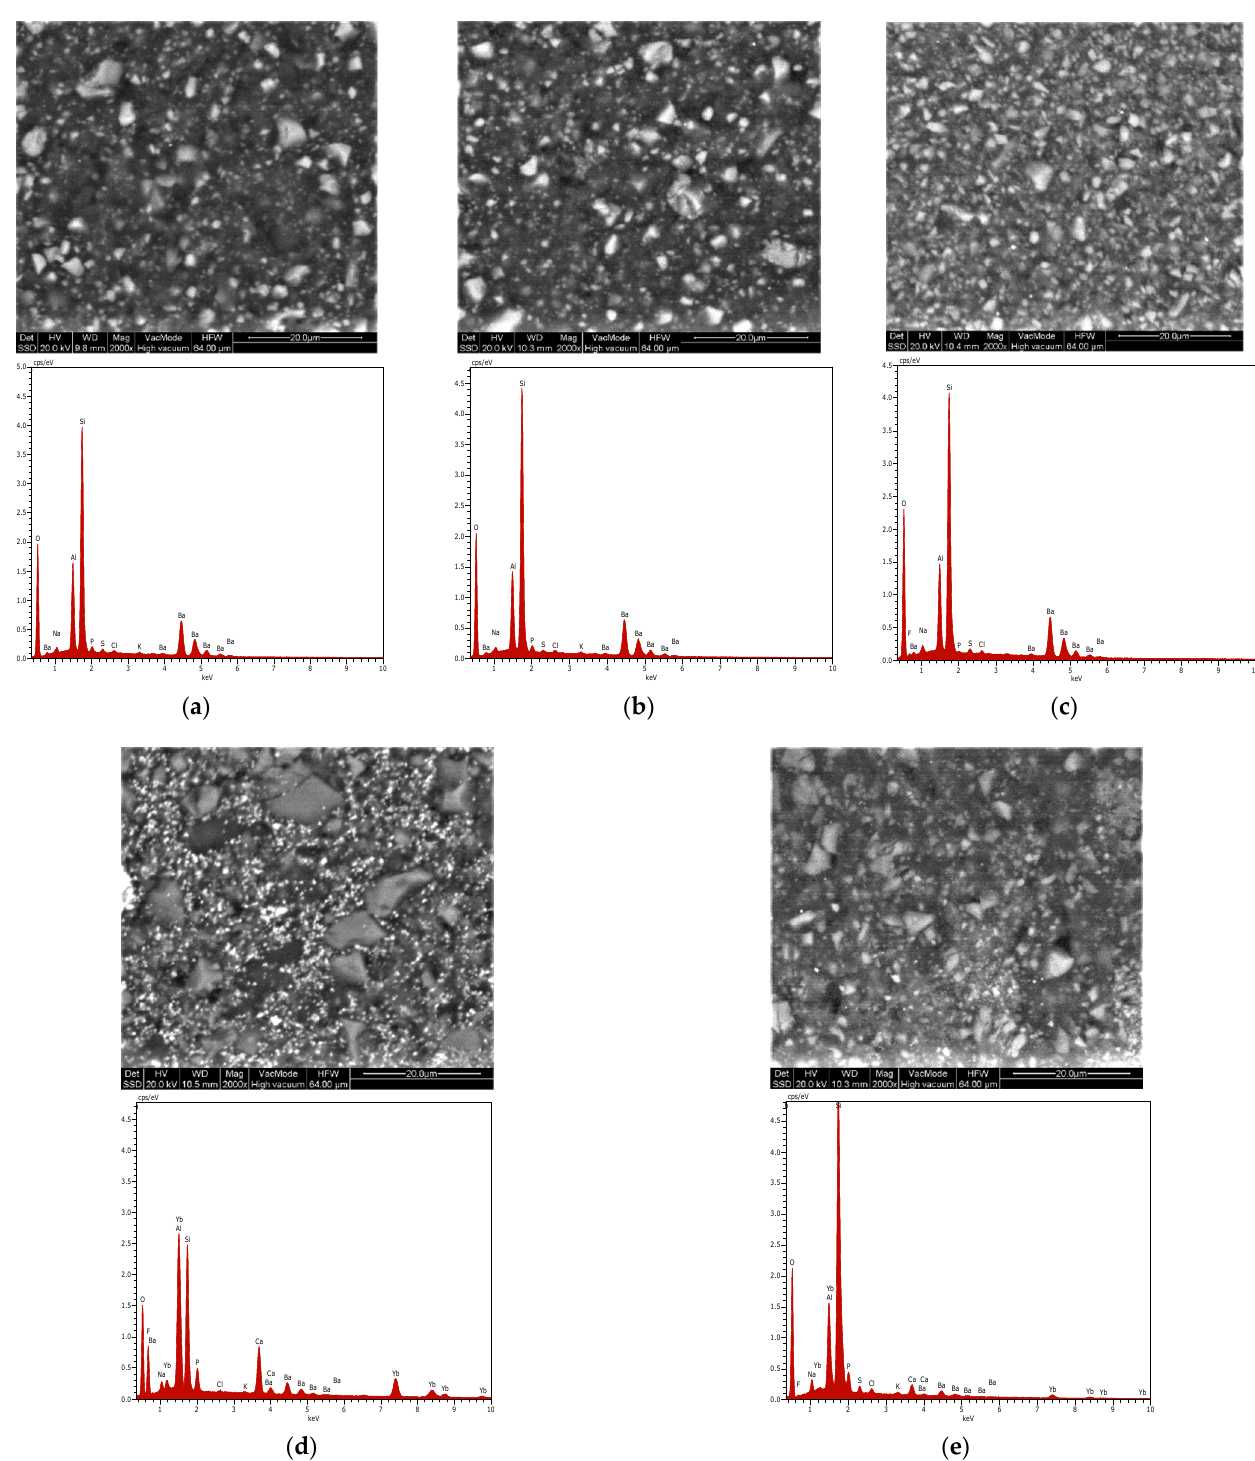
Figure 6. BE images and the corresponding EDX spectra of the products tested. ( a ) PSP, ( b ) PSU, ( c ) PV5, ( d ) SPC and ( e ) THC. (BE images: 2000 × magnification, scale bar: 20 μ m; EDS spectra 64 μ m × 64 μ m area scan analysis). Table 5. The results of the elemental analysis by EDX (atomic %). Product PSU 56.11